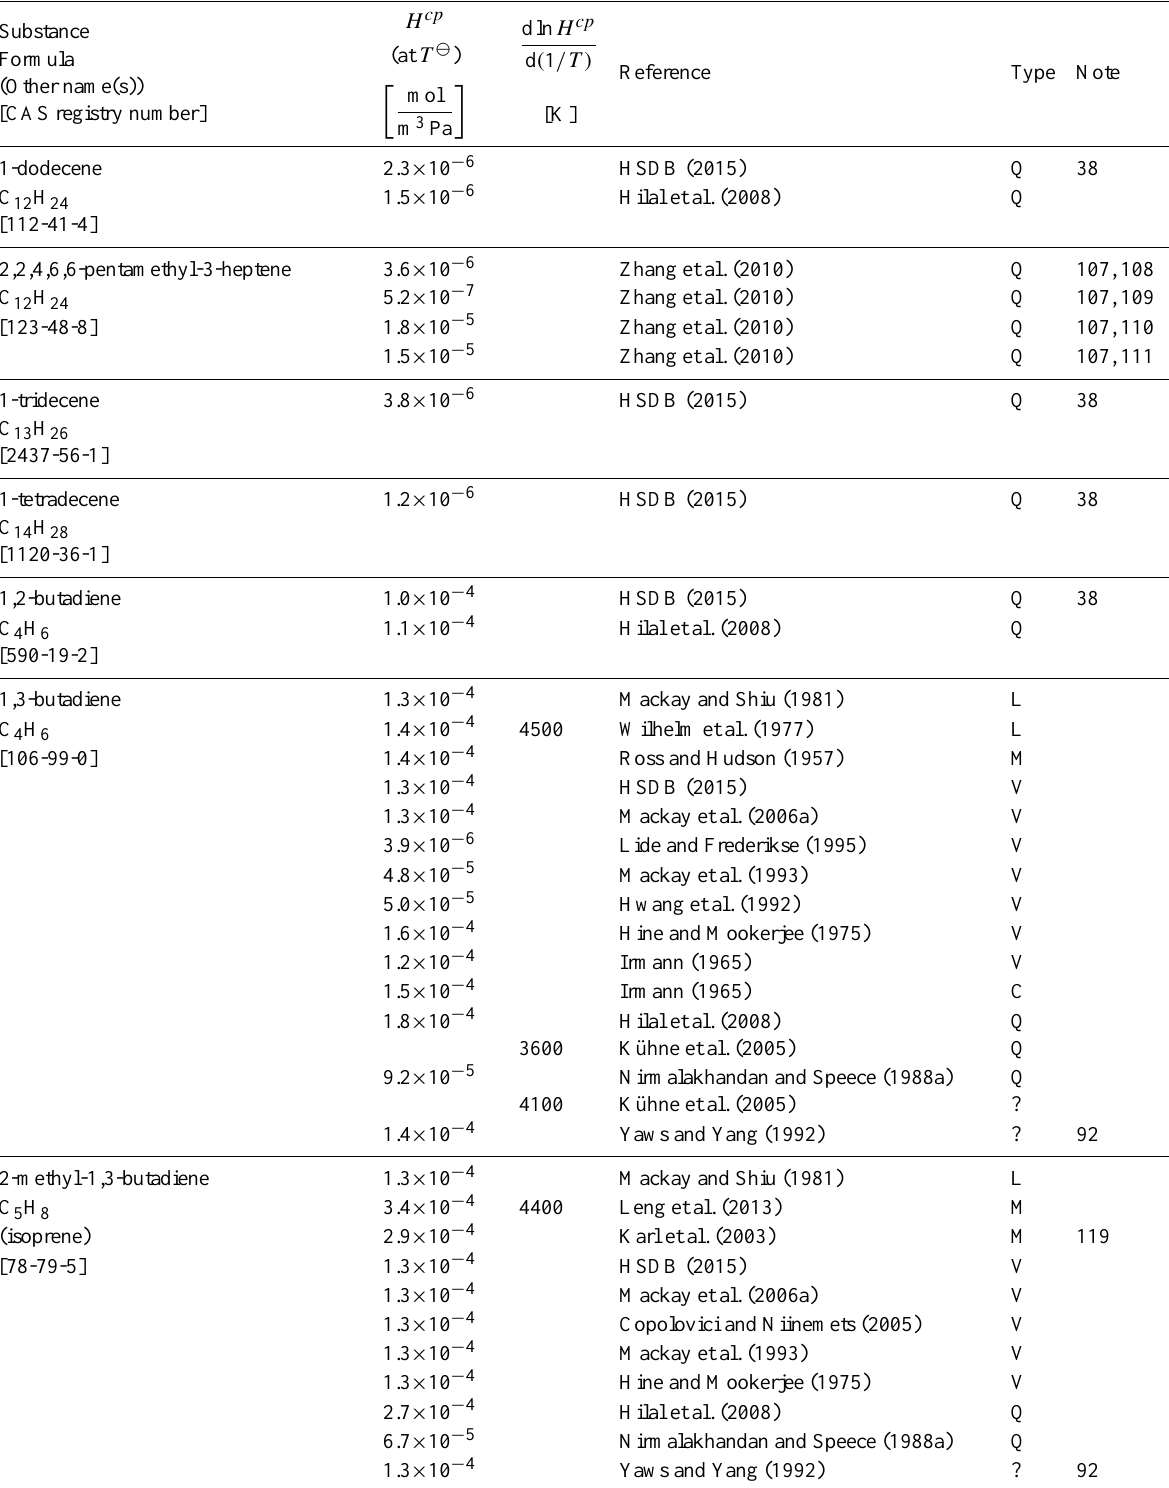
Table 6: Henry’s law constants for water as solvent